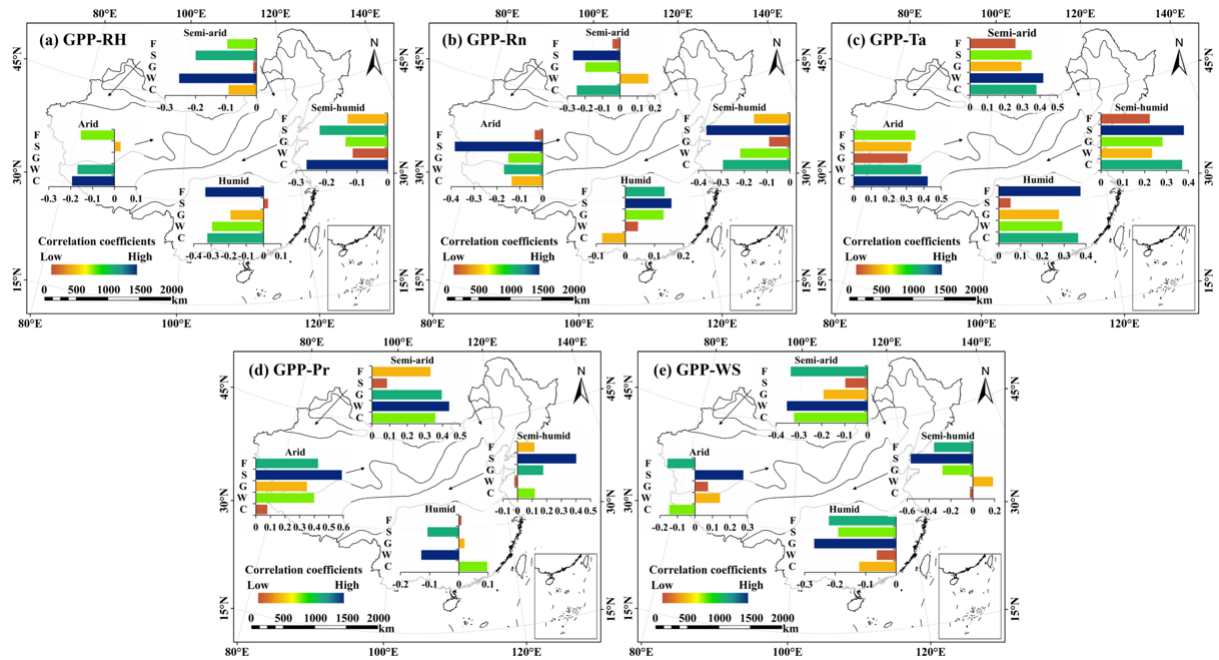
Figure 13. Average correlation coefficients between GPP and climatic factors for each vegetation type in four arid-humid zones from 2001 to 2021. ( a ) Relative Humidity (RH); ( b ) Net radiation (Rn); ( c ) Average temperature (Ta); ( d ) Precipitation (Pr); ( e ) Wind Speed (WS). F: forest; S: shrubland; G: grassland; W: wetland; C: cropland.